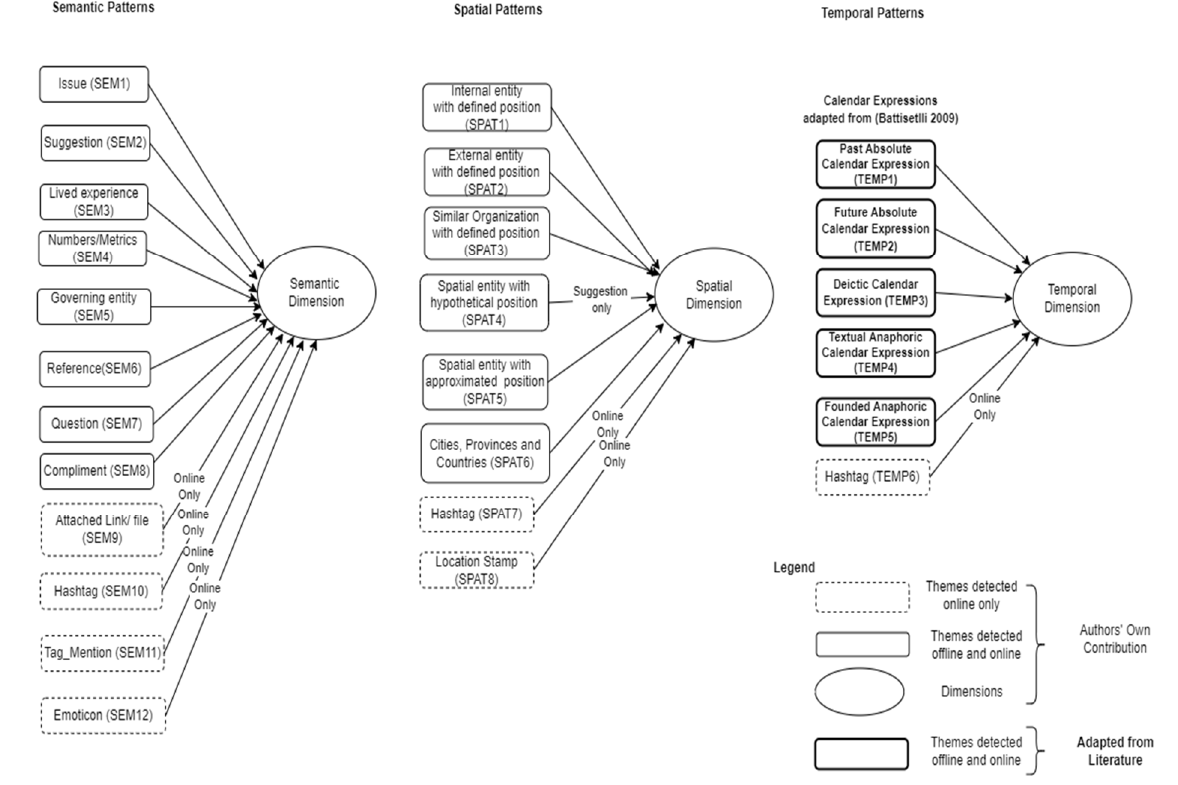
Figure 2. Semantic, spatial, and temporal patterns in SPP data.